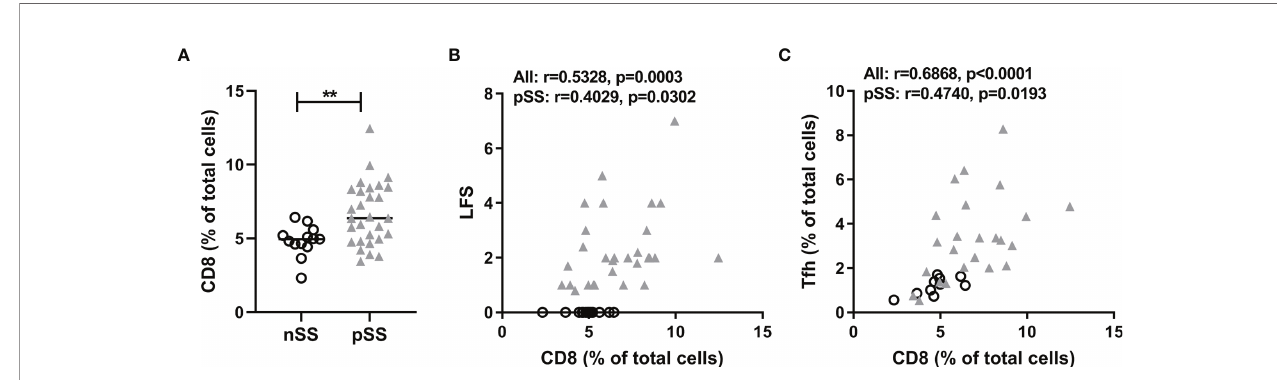
FIGURE 1 | CD8+ T cells are abundantly present in salivary glands in pSS and correlate with lymphocytic foci and T follicular helper cell numbers. Epigenetic cell counting from labial salivary gland tissue DNA was used to determine (A) the percentage of CD8 T cells in nSS versus pSS patients. (B) Spearman ’ s correlation between CD8 T cell percentages and lymphocytic focus scores (LFS). (C) Spearman ’ s correlation between CD8 T cell percentages and Tfh cell percentages. nSS, non-Sjögren sicca; pSS, primary Sjögren ’ s syndrome; LFS, lymphocytic focus score; Tfh, T follicular helper. ** indicates statistical signi fi cance